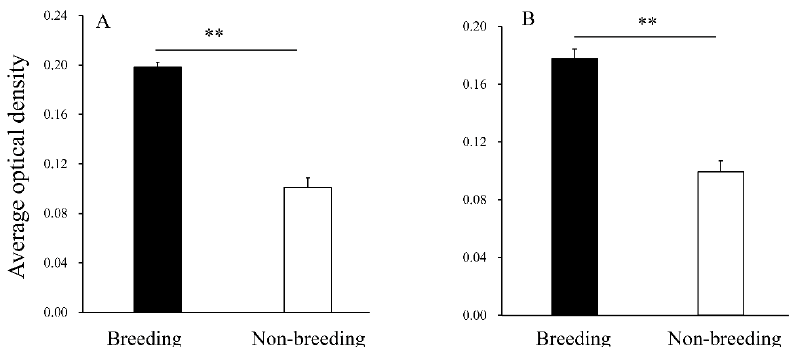
Figure 3. Average optical densities of immunopositive signals of luteinizing hormone receptor (LHR) and follicle stimulating hormone receptor (FSHR) during the breeding and non-breeding season. (A) : average optical densities of immunopositive signals of LHR; (B) : average optical densities of immunopositive signals of FSHR. Bars represent means ± standard deviations of two independent